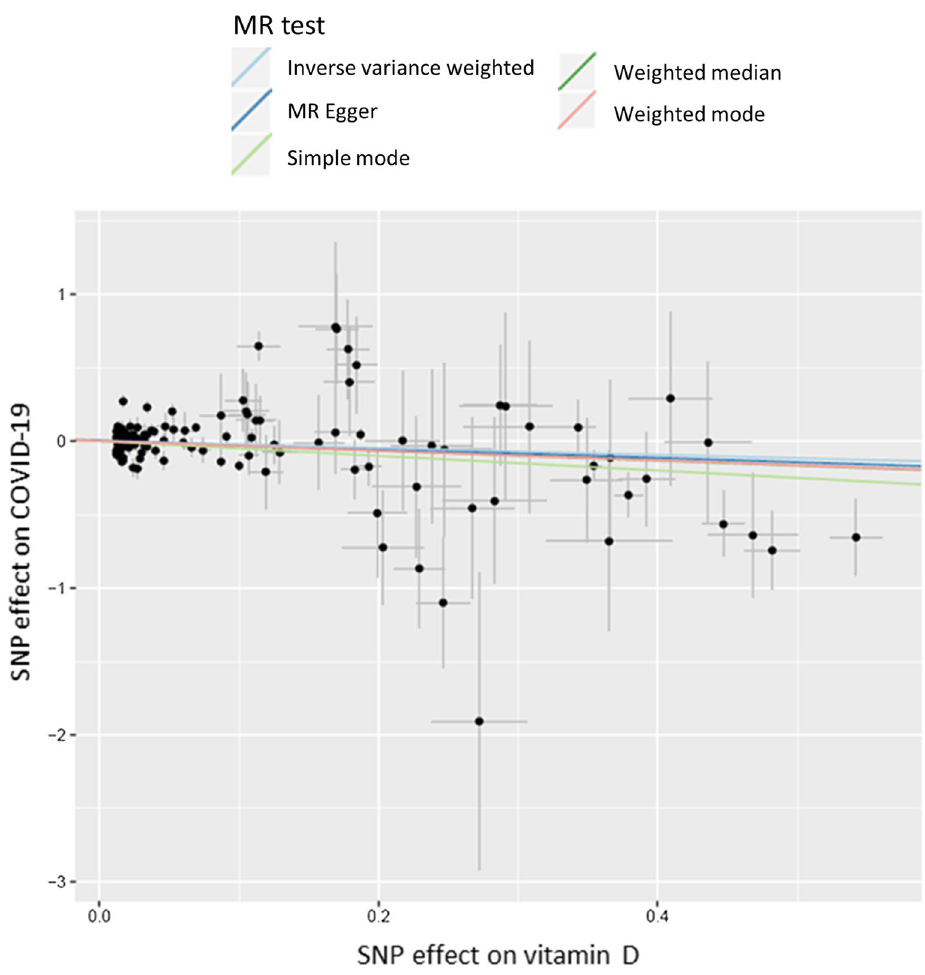
Figure 1. A scatter plot of Mendelian Randomisation analyses of 134 vitamin D SNPs on COVID-19